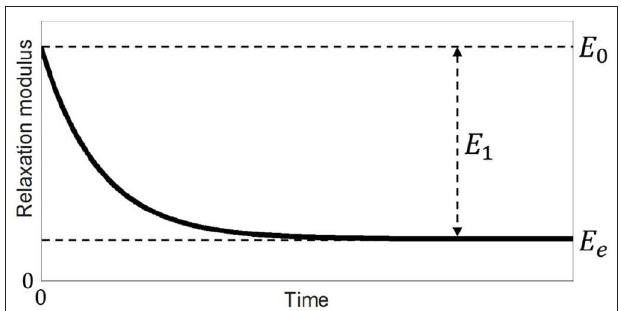
FIGURE 3 | Illustration of E 0 , E e and E 1 . E 0 is the relaxation modulus at the beginning of stress relaxation. E e is the constant relaxation modulus as t → ∞ , and is the modulus of elasticity of the material. E 1 can be interpreted as how much the relaxation modulus drops from the beginning of stress relaxation to the constant relaxation modulus as t → ∞